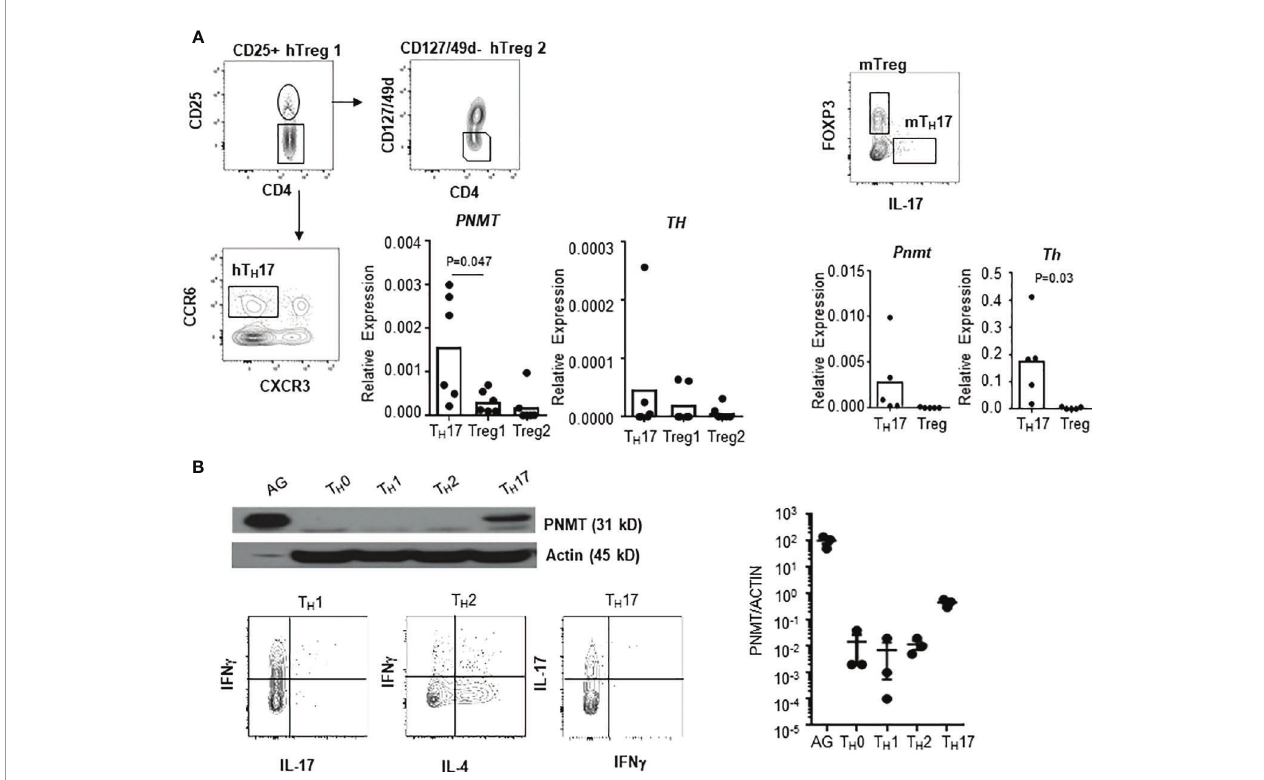
FIGURE 3 | Th and PNMT expression in human and mouse helper T cell subsets. (A) Th and PNMT expression in Treg cells and Th17 cells. Human CD25+ Treg cells (hTreg1 in fi gure), CD127lo Treg cells (CD49d-CD127 lo CD25+) (hTreg2 in fi gure) and T H 17 cells (CD25-CXCR3-CCR6+) was isolated from PBMCs and murine FOXP3+ Treg and T H 17 cells were isolated from spleen of 6-8 weeks of Foxp3 -GFP C57BL/6 mice. Total RNA was isolated and Th and PNMT expression was measured by qPCR. One representative image from 2 independent experiments (n = 6). (B) Mouse CD4+ T H cells were differentiated from naïve CD4+ T cells and protein level of PNMT was measured by western blot. Differentiation was con fi rmed by cytokine production of IFN g (T H 1), IL-4 (T H 2), and IL-17 (T H 17) at the end of culture. Levels of actin was measured as a protein loading control. One representative image of 3 independent experiments. Intensity of protein expression was quanti fi ed by densitometry and normalized to the level of